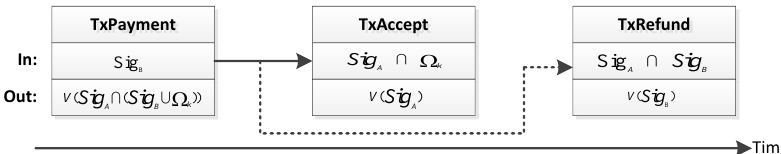
Figure 4. Three types of